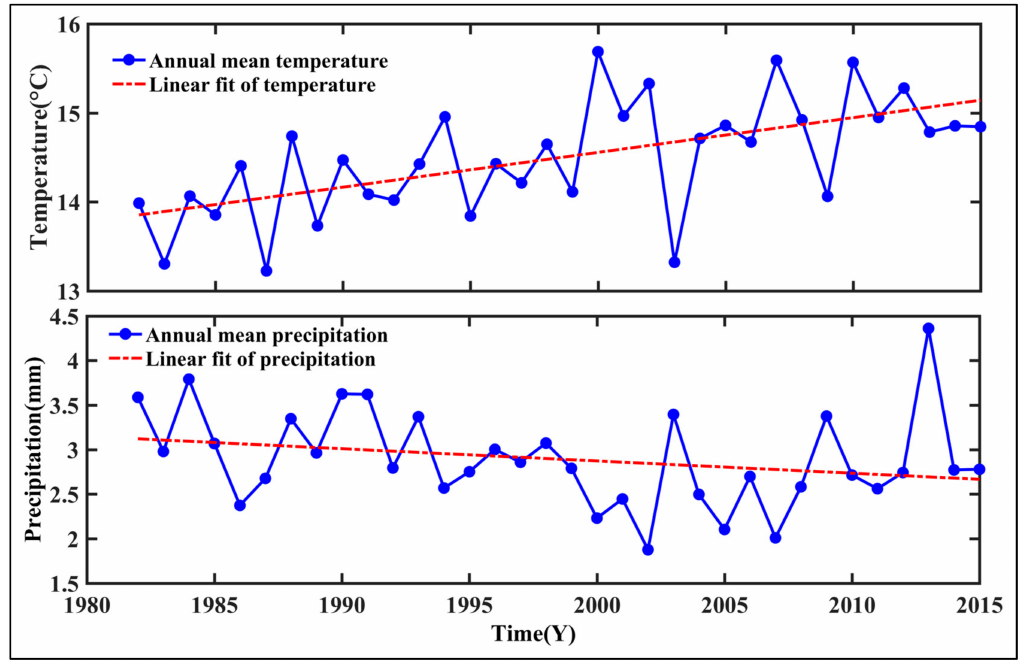
Figure 13. Variation in annual mean daily temperature and annual mean daily precipitation in the growing season over the GKM from 1982 to